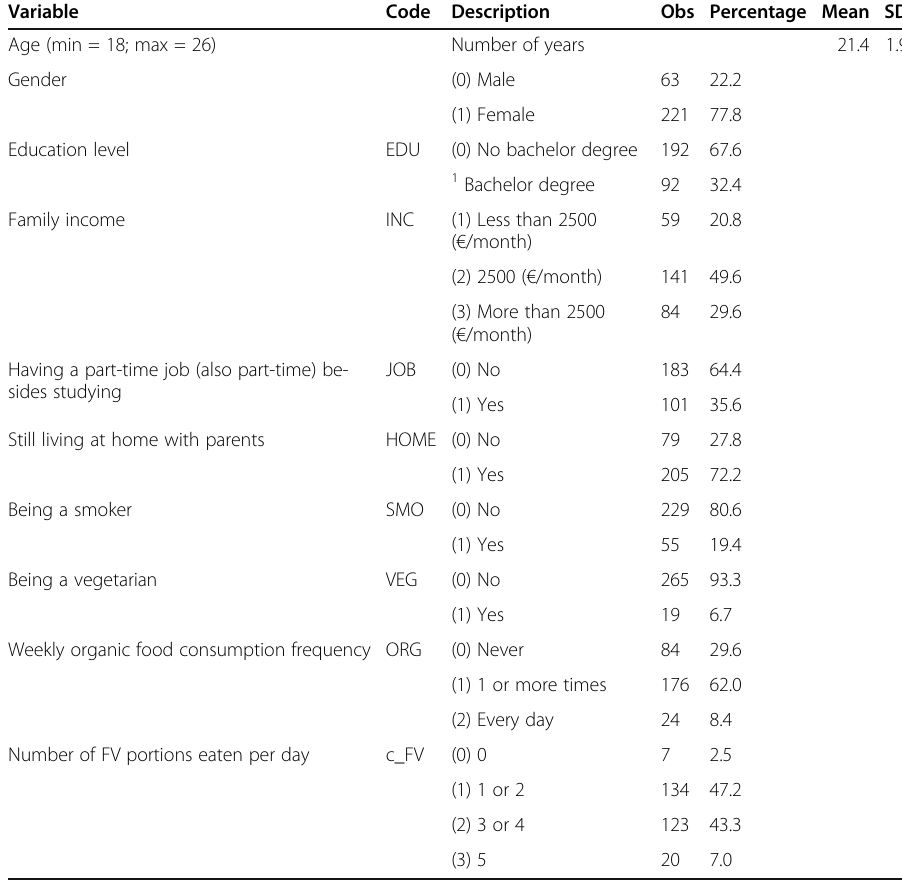
Table 2 Sample descriptive statistics (N =